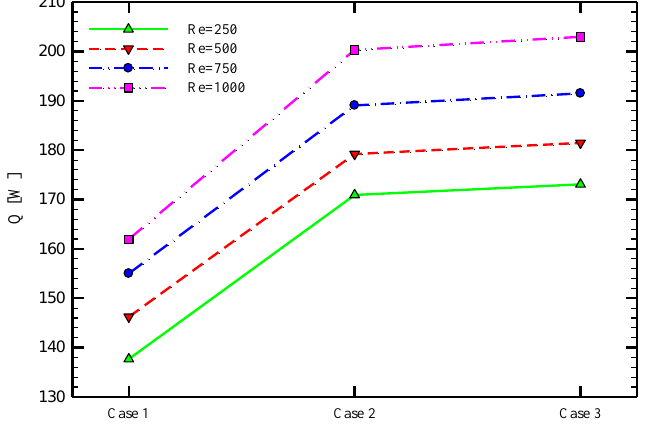
Figure 5. Local bulk temperature distribution along the length of the tube for PHE, Co-STT and Counter-STT at Reynolds number of 250.